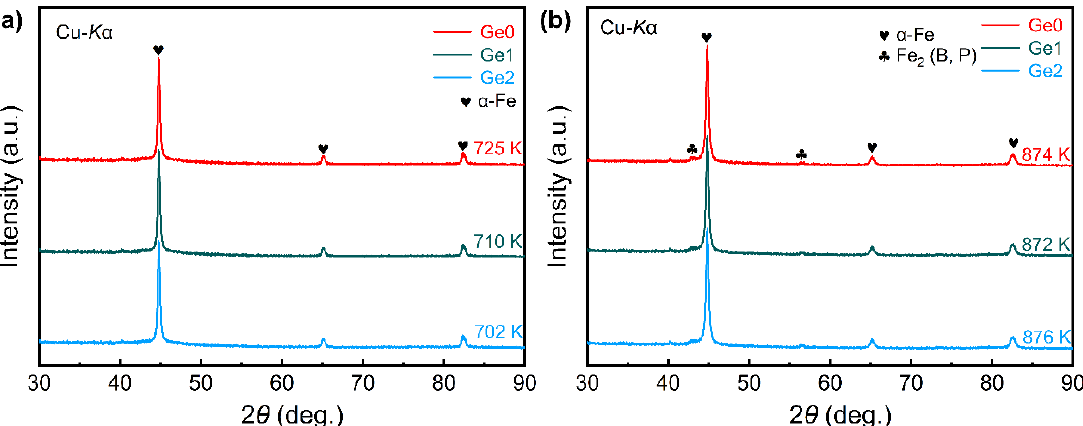
Figure 2. XRD patterns of Fe 80.2 Si 3 B 12- x P 2 Nb 2 Cu 0.8 Ge x ( x = 0, 1, 2 at.%) alloys produced by continu- ously heating to a temperature just beyond the T x 1 ( a ) and T x 2 ( b ) at a heating rate of 40 K/min and then cooling them down to room temperature as fast as possible in a DSC.